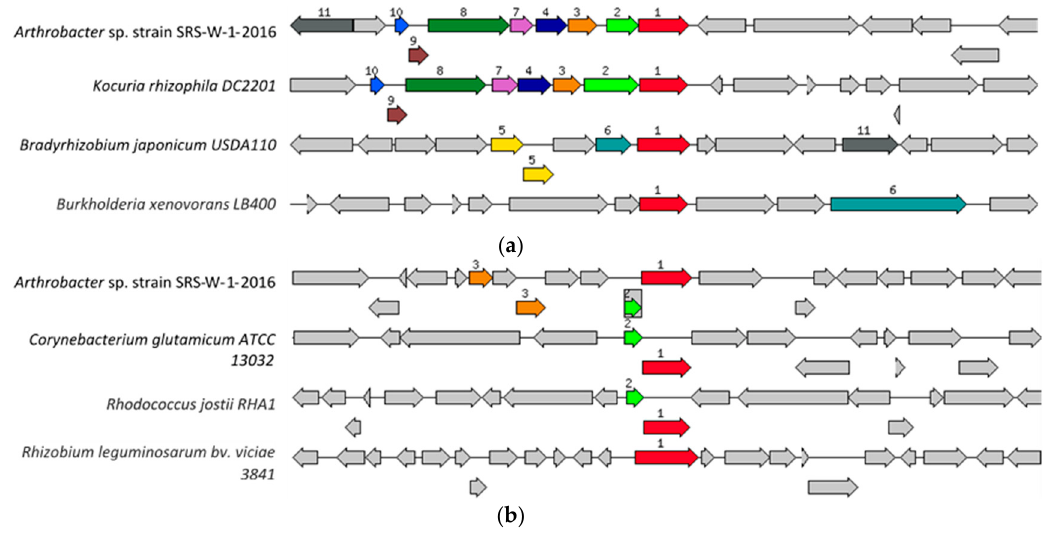
Figure 4. Shown are ( a ) the chromosomal region of the cobalt/zinc/cadmium subsystem gene (1056 bp) in Arthrobacter sp. strain SRS-W-2-2016 relative to four other organisms and ( b ) the HoxN / HupN / NixA family nickel/cobalt transporter gene (1089 bp) in Arthrobacter sp. strain SRS-W-2-2016 relative to four other organisms. The graphic is centered on the focus gene, which is red and numbered 1. Sets of genes with a similar sequence are grouped with the same number and color. Genes whose relative position is conserved in at least four other species are functionally coupled and share gray background boxes.